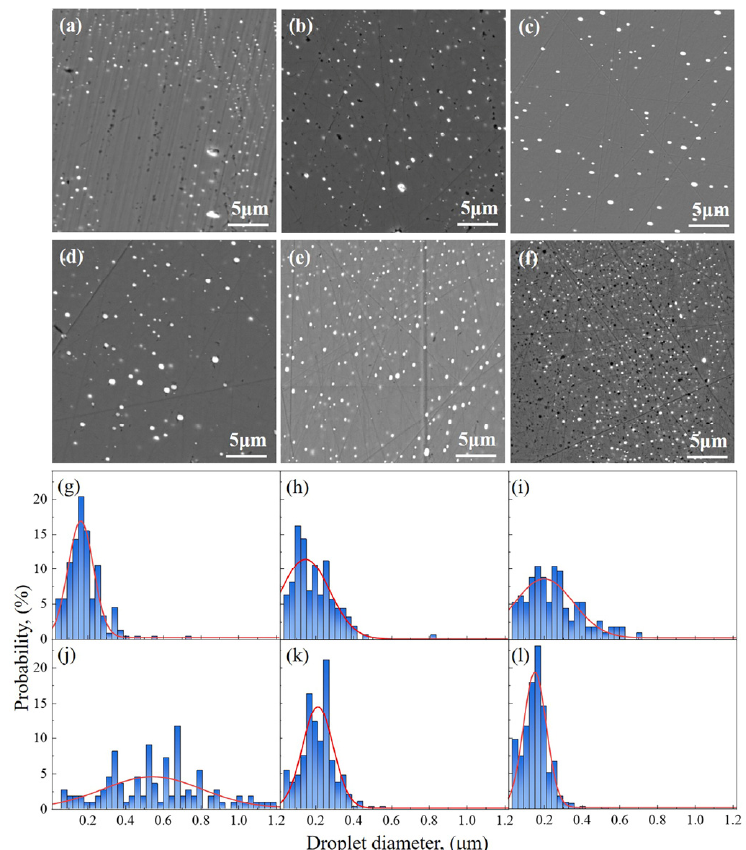
Figure 4. The morphologies and particle size distributions of the Bi-rich phases ahead of the S-L interface in the case of the growth rate of 5 µ m/s under various MFDs. ( a , g ) 0 T; ( b , h ) 0.1 T; ( c , i ) 0.5 T; ( d , j ) 1 T; ( e , k ) 3 T; ( f , l ) 5 T. ( a – f ) The morphologies of Bi-rich droplets ahead of the S-L interface under various MFDs. ( g – l ) The size distributions of Bi-rich droplets ahead of the S-L interface under various MFDs.